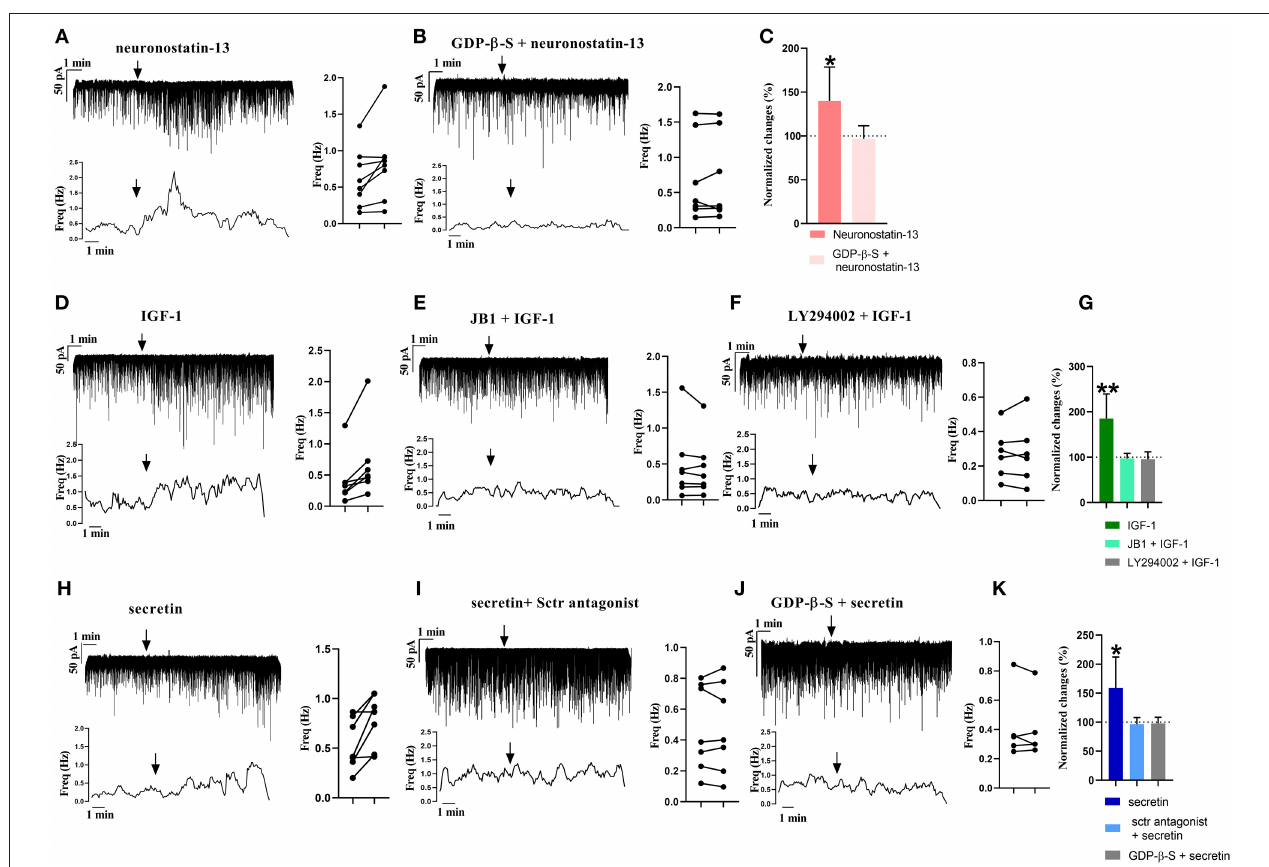
FIGURE 3 | Electrophysiological validation of functional peptide/growth factor receptors expressed in GnRH neurons of metestrous mice. Changes in the frequency of mPSCs after administration of different substances. Under each representative recording, the corresponding frequency distribution graph is shown. On the right, the control and treated mPSC frequency of each cell is displayed individually (paired t -test * p < 0.05). Arrow shows the application of the drugs. (A) Significant increase in the mPSCs is observed after neuronostatin treatment. (B) Application of intracellular GDP- β -S prevented the effect of neuronostatin-13. (C) Bar graph shows the normalized changes after neuronostatin-13 and antagonist treatment. Control period was considered as 100% (Student’s t -test; * p < 0.05). (D) IGF-1 increases frequency of mPSCs. (E) JB1 abolished the effect of IGF-1. (F) In the presence of intracellularly applied PI3K blocker LY294002, IGF-1 application did not elevate the frequency. (G) Bar graph shows the normalized changes after IGF-1 application on mPSCs, and after the IGF-1 receptor antagonist JB1 or intracellularly used Pi3K blocker LY294002 treatment. Control period was considered as 100% (Student’s t -test; ** p < 0.01). (H) Secretin elevated the frequency of mPSCs. (I) Sctr antagonist prevented the effect of secretin. (J) Effect of secretin in the presence of intracellularly used GDP- β -S. (K) Bar graph shows the normalized changes after the applied treatments. Control period was considered as 100% (Student’s t -test; * p <